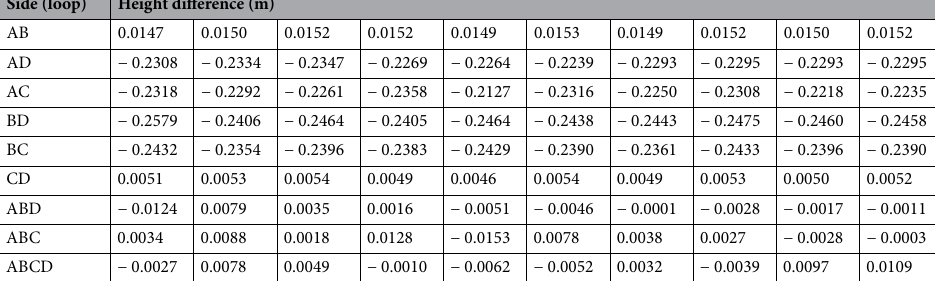
Table 4. Results of adjusted height difference. The standard deviation for per kilometer: